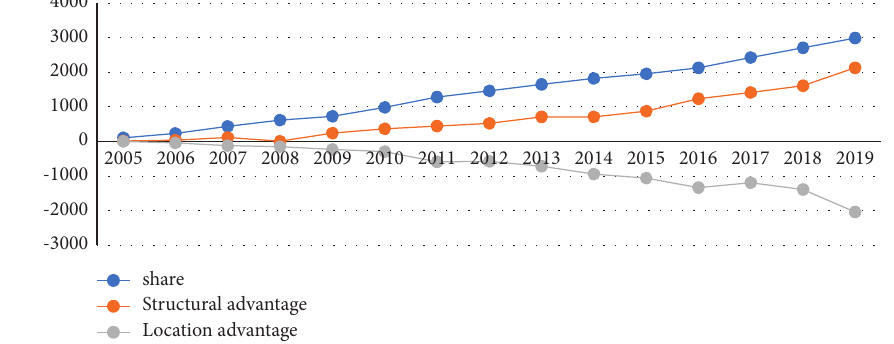
Figure 4: T&U trend of finance.